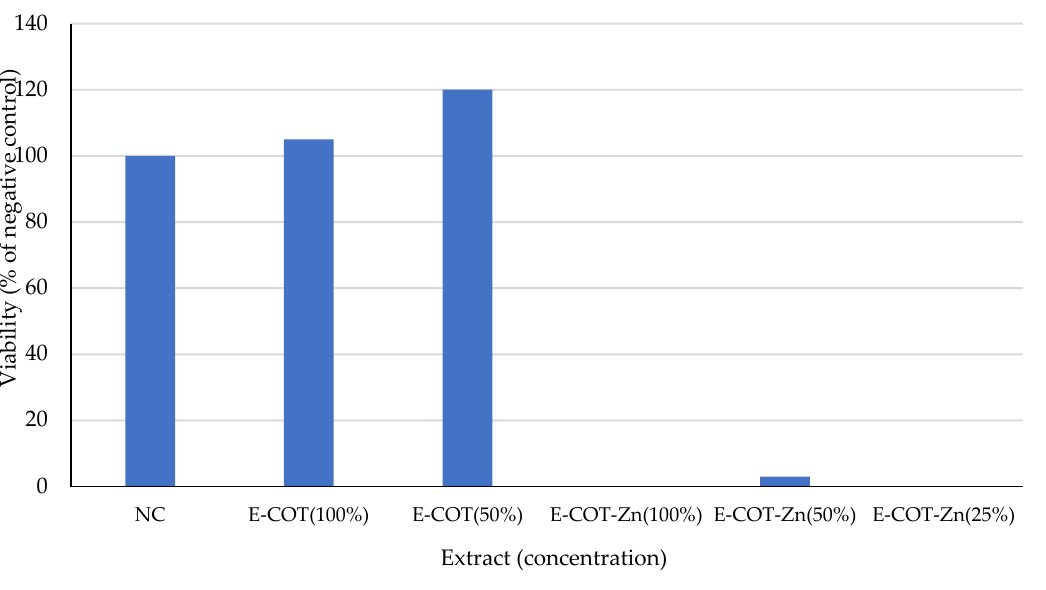
Figure 10. Effect of 24 h exposure of BALB/3T3 clone A31 cells on unmodified and modified cotton extracts, determined with the NRU test. Viability is shown as a percentage of the negative control (NC; exposure medium treated analogously to the extracts).